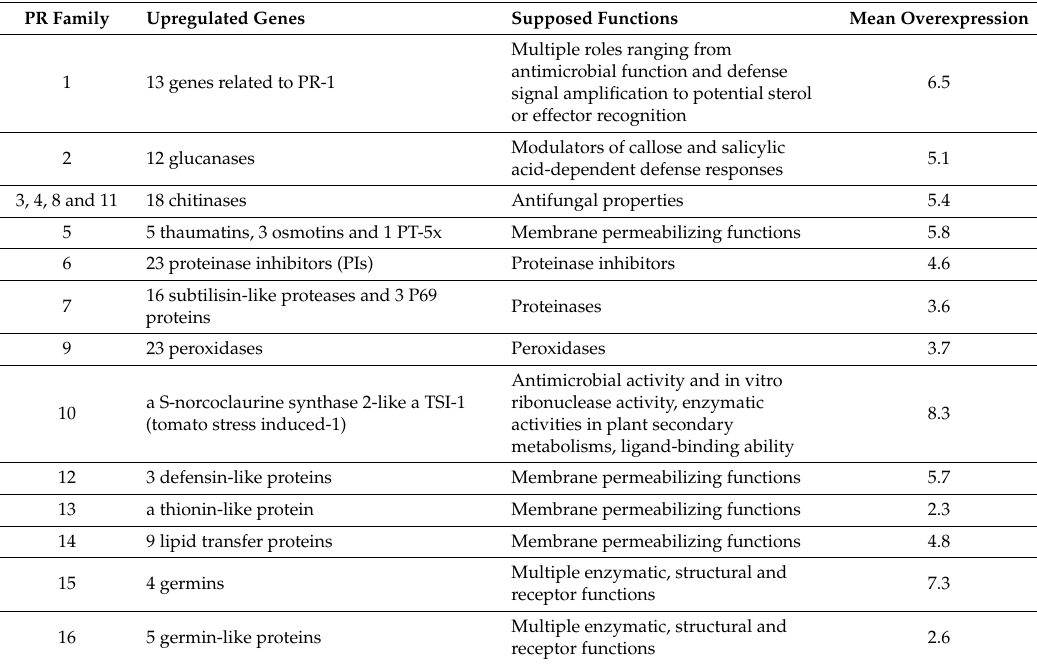
Table 1. Significantly upregulated PR genes (LogFC > 1 and FDR < 0.05) in infected plants